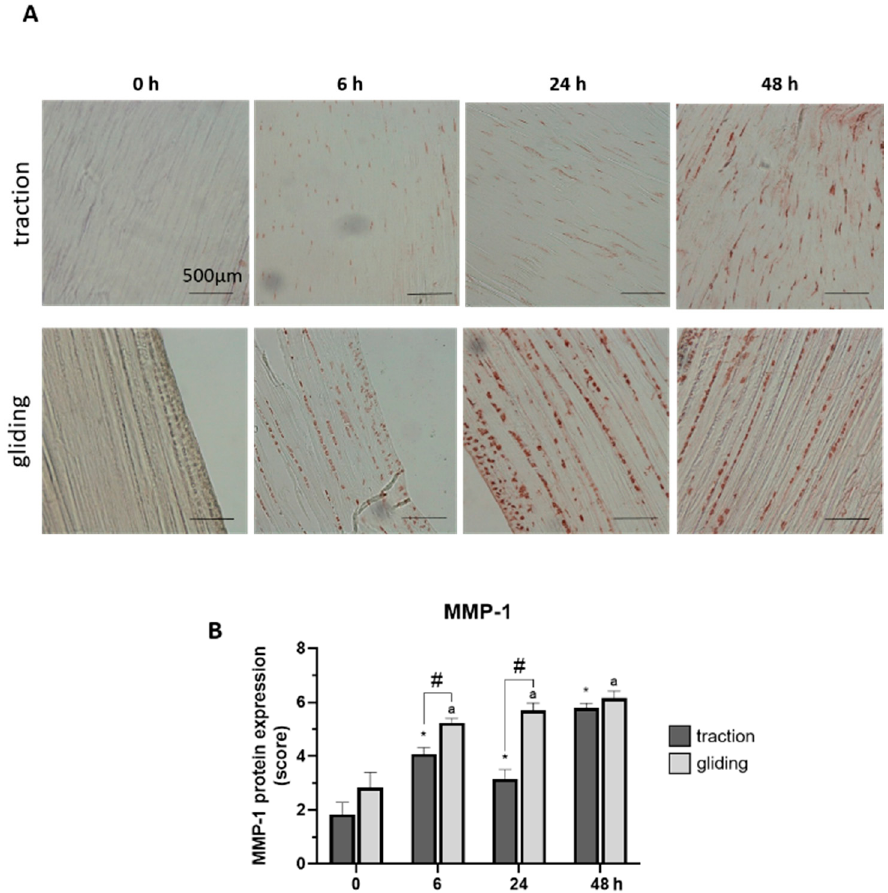
Figure 4. Effects of uniaxial treatment on matrix metalloproteinase-1 (MMP-1) expression in traction and gliding areas of tendons. ( A ) Representative images of immunohistochemically stained sections against MMP-1 in traction (upper panel) and gliding (lower panel) regions after 48 h of uniaxial force application. ( B ) Scoring of MMP-1 in the traction region revealed a significant increase after 6 h with